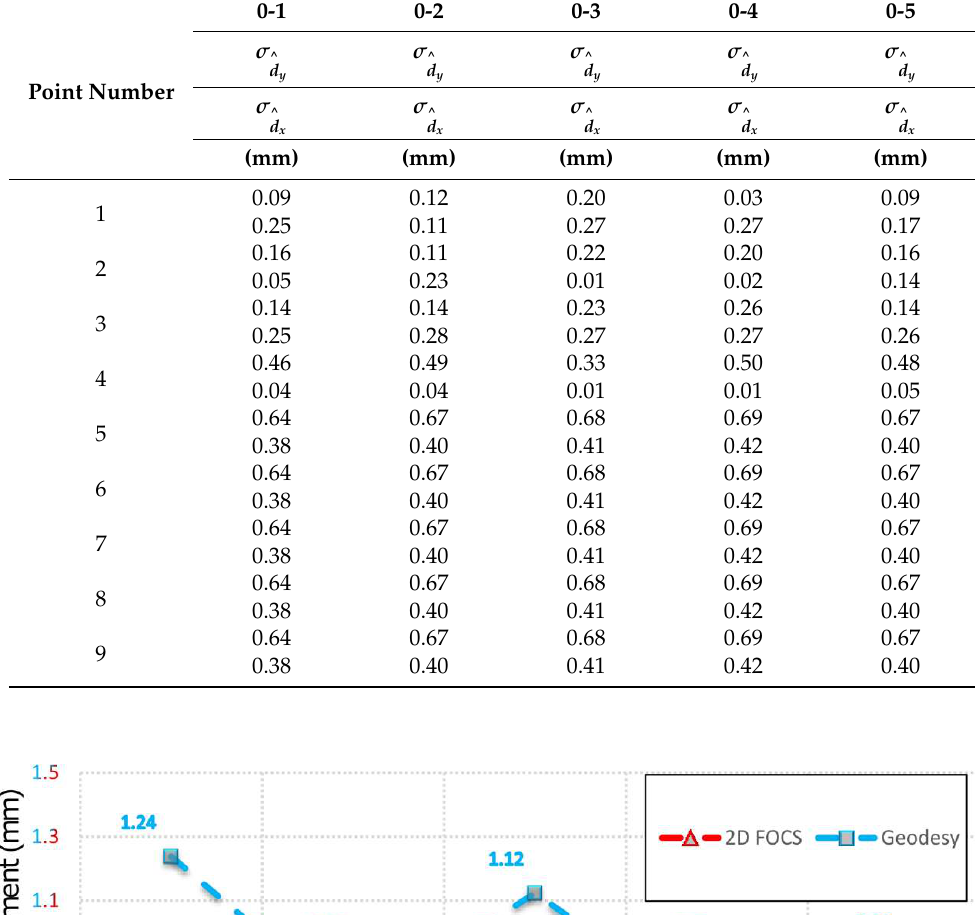
Table 4. Standard deviations of displacement vector components.